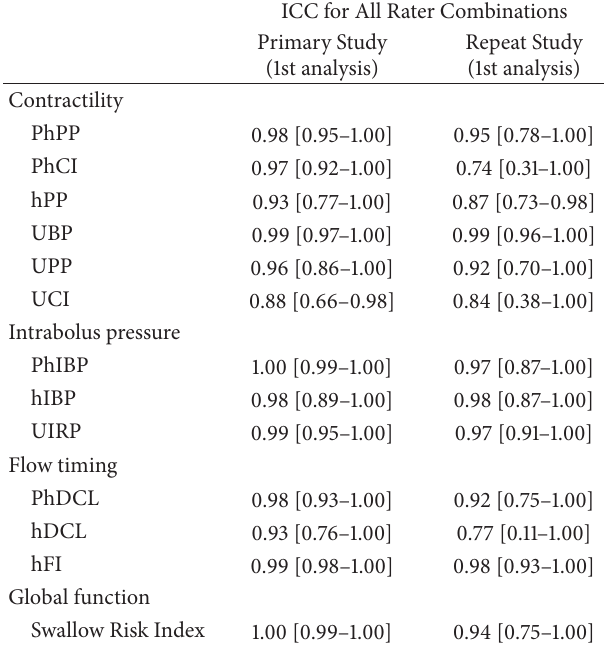
Table 2: Interrater reliability of all rater combinations for the 1st analysis of the Primary and Repeat Studies. Data are average ICC [range ICC].